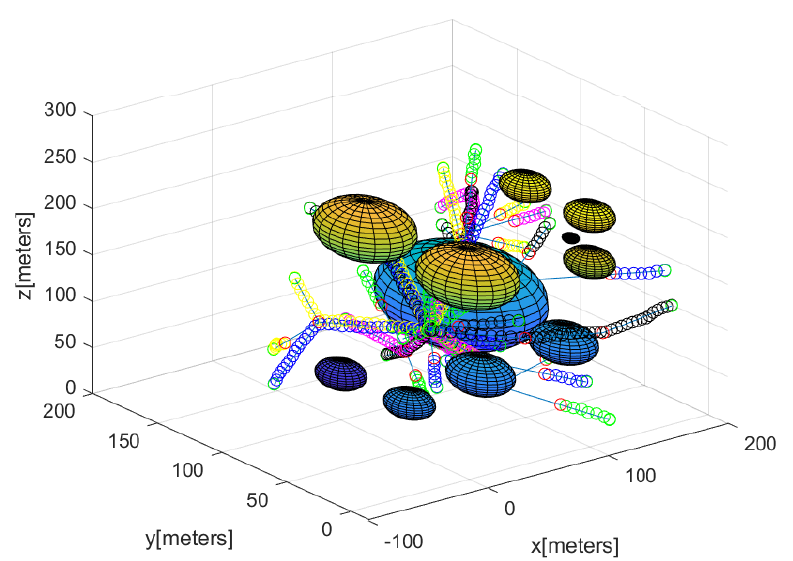
Figure 12. Every UUV’s maneuver once the rendezvous is completed (the waypoint approach is utilized). Every UUV’s maneuver is illustrated as circles with a distinct color. At t = 0 s, we build a tree T (blue line segments) containing all UUVs. A total of 25 broken UUVs are illustrated with red circles. Healthy UUVs use broken UUVs as waypoints for reaching the root. Obstacles are plotted with spheres.